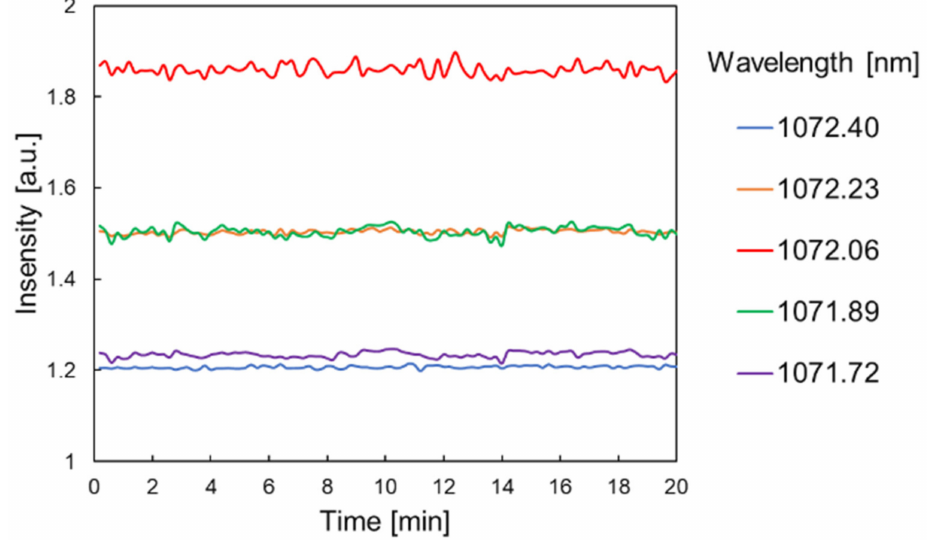
Figure 6. Stability of five-wavelength generation based on four-wave